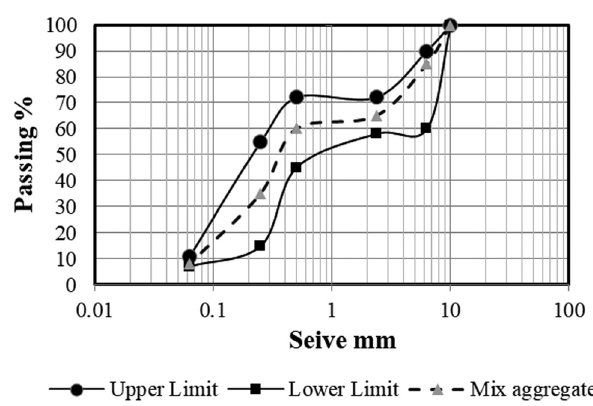
Figure 1: Distribution of particle size of the aggregate.